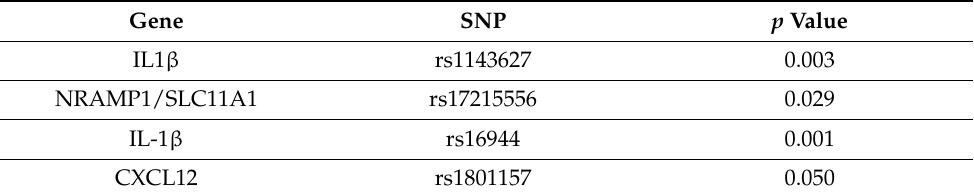
Table 4. BCG treated MMAIT stage III melanoma patient cutaneous DTH response to PPD correlation to immune gene SNP